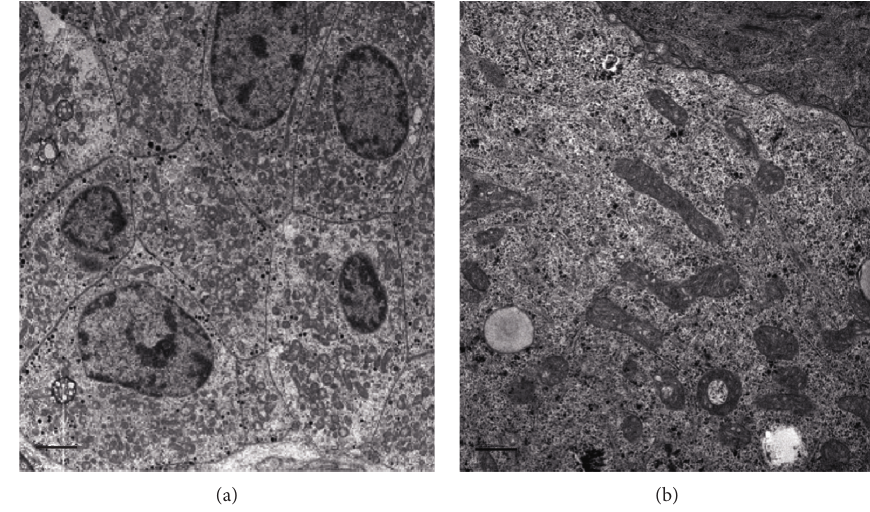
Figure 3: Electron microscopy findings: (a) electron micrographs show adrenal oncocytoma cells, characterized by the presence of large amount of mitochondria (scale bar represents 2 μ m). (b) high magnification displays ultrastructural details of crista-type mitochondria (scale bar represents 0.2 μ